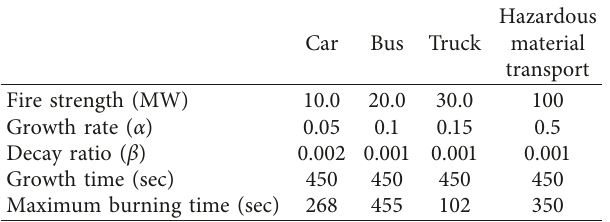
Table 6: Properties of standard fire curve [27].